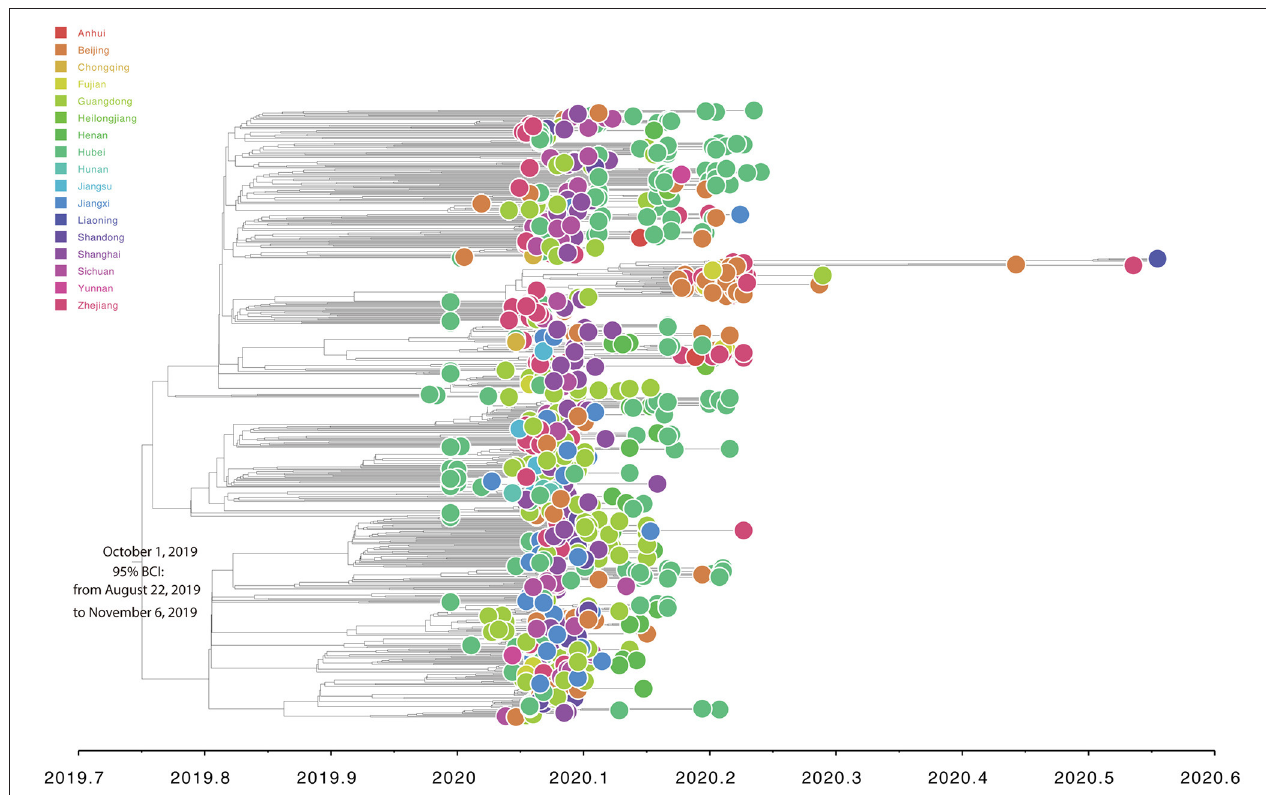
FIGURE 5 | Estimated Bayesian time-scaled maximum-clade-credibility phylogenetic tree of SARS-CoV-2 from Mainland China. Circle at the tip is colored according to sampling provinces from Mainland China. Note that the axis of abscissas is scaled by decimal